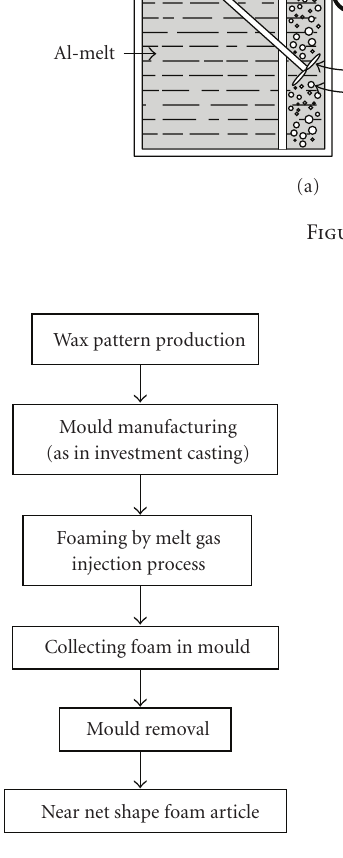
Figure 2: Work flow of MGI-mould process.